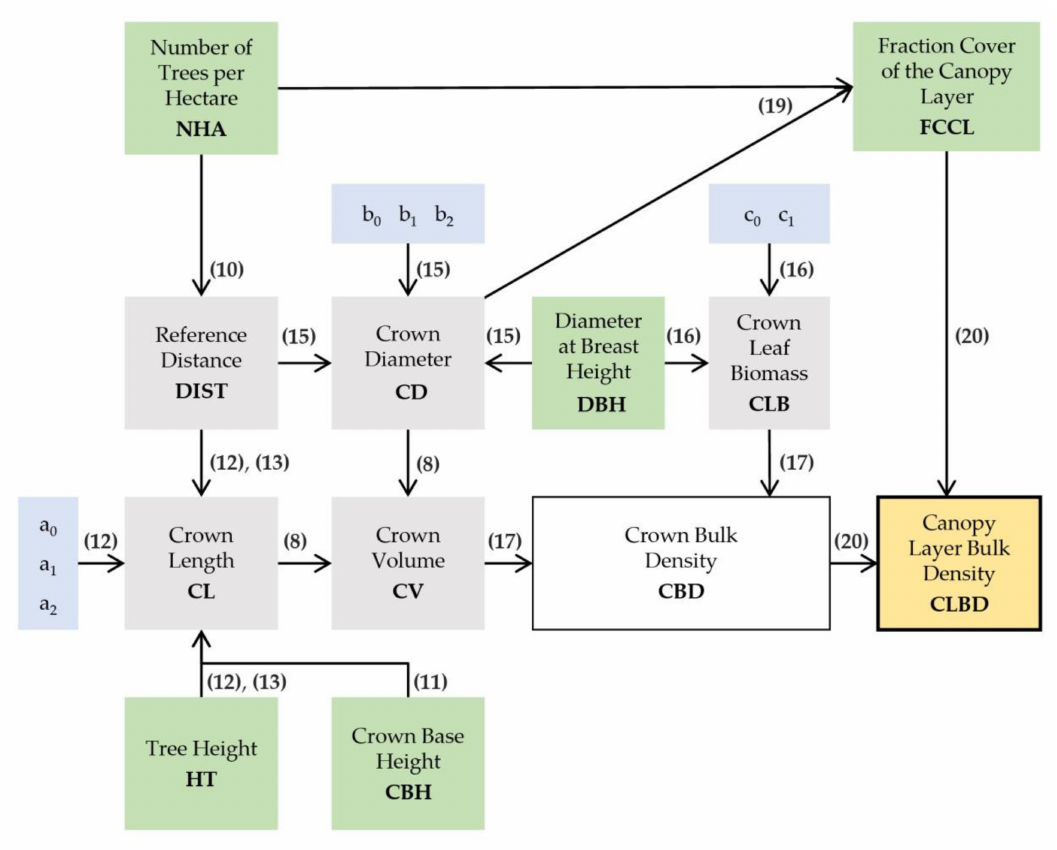
Figure 5. Dependency of Canopy Layer Bulk Density (CLBD) on the different independent variables. Numbers indicate the corresponding equations. Green boxes represent variables from Forest Invento- ries. Blue boxes are ancillary variables and parameters from supplementary work estimated for each forest type. White boxes are intermediate results. The yellow box represents the final output for fire behavior